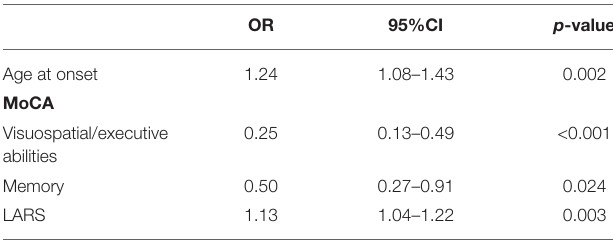
TABLE 3 | Correlative clinical factors of SCCs in the patients with